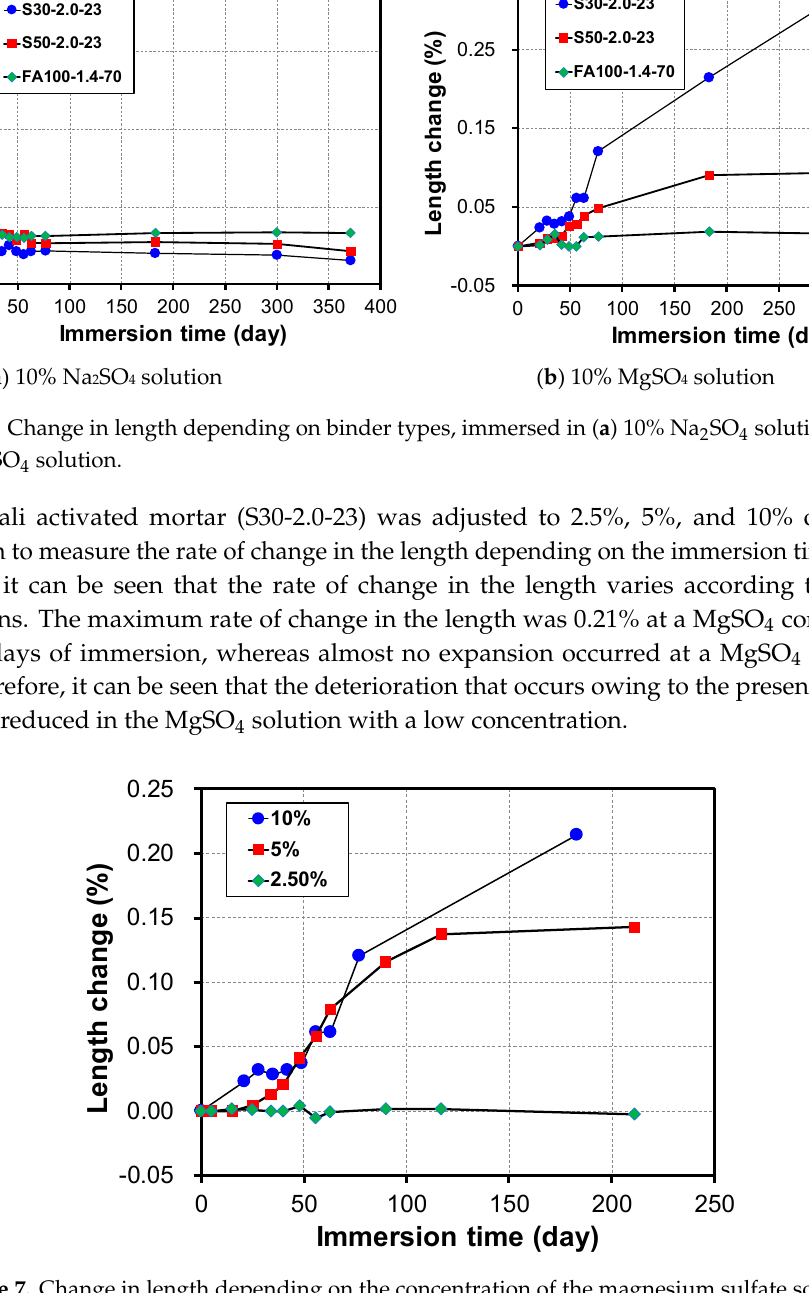
Figure 7. Change in length depending on the concentration of the magnesium sulfate solution.